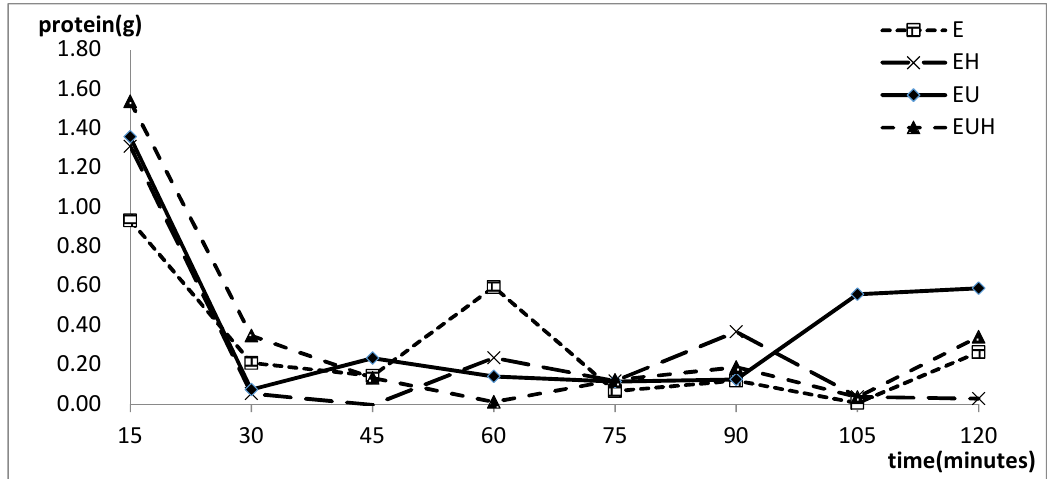
Figure 2. The absorption changes in different groups with time.